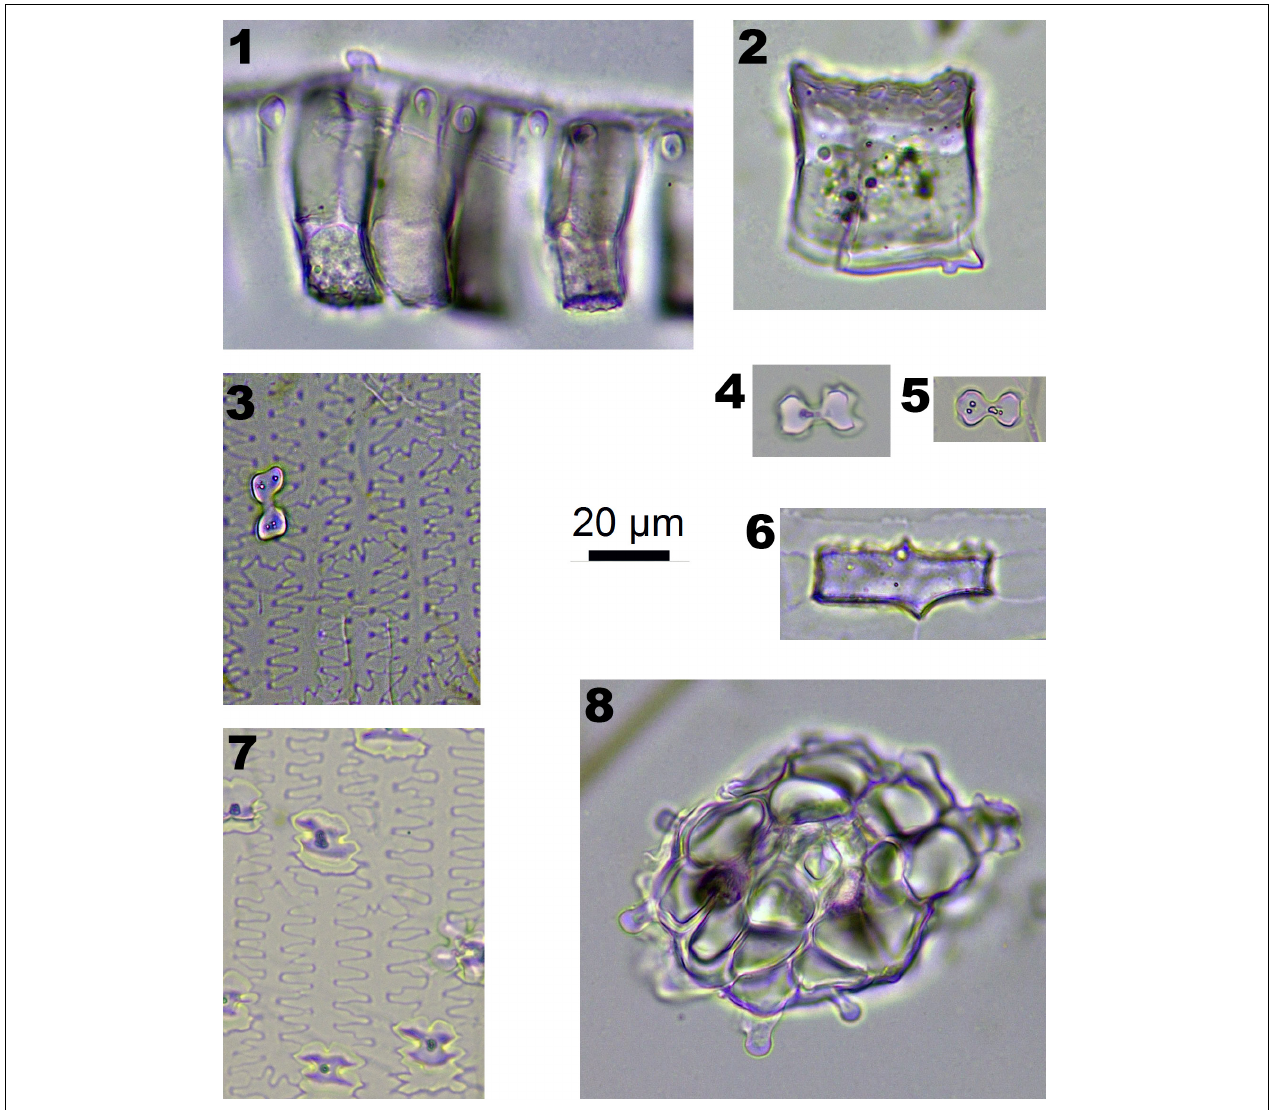
FIGURE 3 | Phytoliths morphotypes in Panicoideae plants. 1 and 2. Bottom and side view of B ULLIFORM ; 3 and 7. I NTERDIGITATING ; 4 and 5. B ILOBATE ; 6. B LOCKY ; and 8. S PHEROIDAL FAVOSE